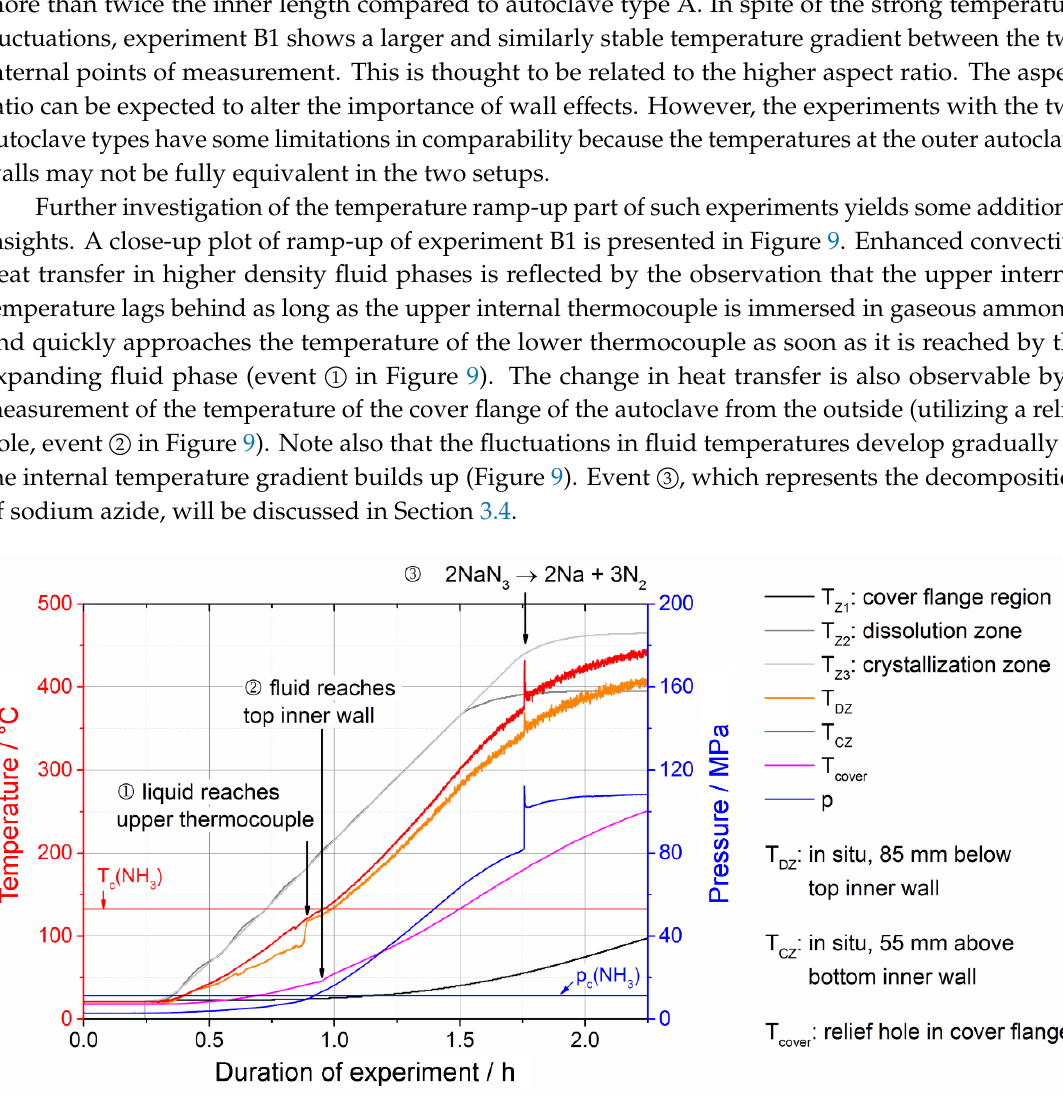
Figure 9. Temperature ramp up part of experiment B1. The features in the internal temperature charts correspond to: ① liquid–gas phase boundary of sub-critical ammonia reaches the measurement tip of the upper internal thermocouple, ② liquid–gas phase boundary reaches the top inner wall, ③ the mineralizer precursor NaN 3 decomposes. Note also that the fluctuations of fluid temperatures develop gradually as the temperature gradient between the two points of measurement increases. For an illustration of the locations of measurement see Figure 1. Critical parameters of NH 3 are also given, showing that the described events are not related to the critical point. Reprinted from [21].